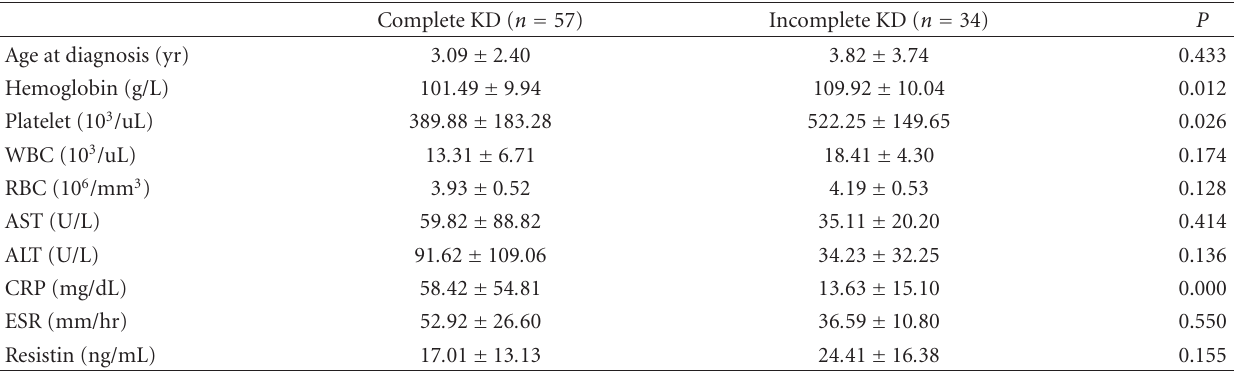
Table 3: Clinical and laboratory variables at admission in the groups with complete and incomplete